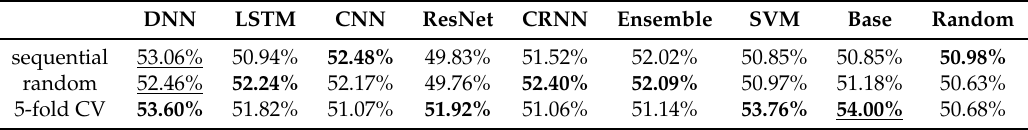
Table 10. Effect of data split methods on classification (accuracy). The sequence size m = 50. The log values of the major features and the first value-based normalization were used.